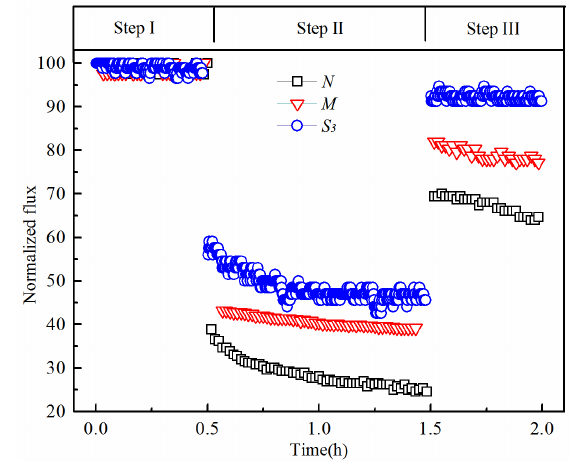
Figure 12. Antifouling performance of membranes N , M and S 3 (total polymer concentration of 20 wt %). Table 4. Calculation of the membrane resistance for membranes N , M and S 3 . Table 4. Calculation of the membrane resistance for membranes N , M and S 3 . Table 4. Calculation of the membrane resistance for membranes N , M and S 3 .